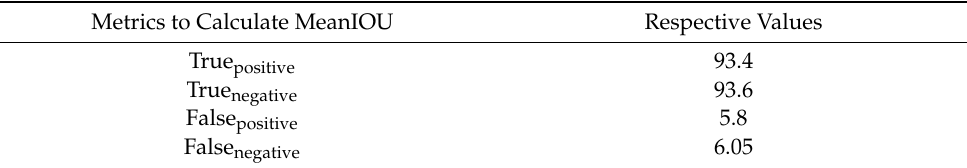
Table 3. Internal Metrics in MeanIOU.